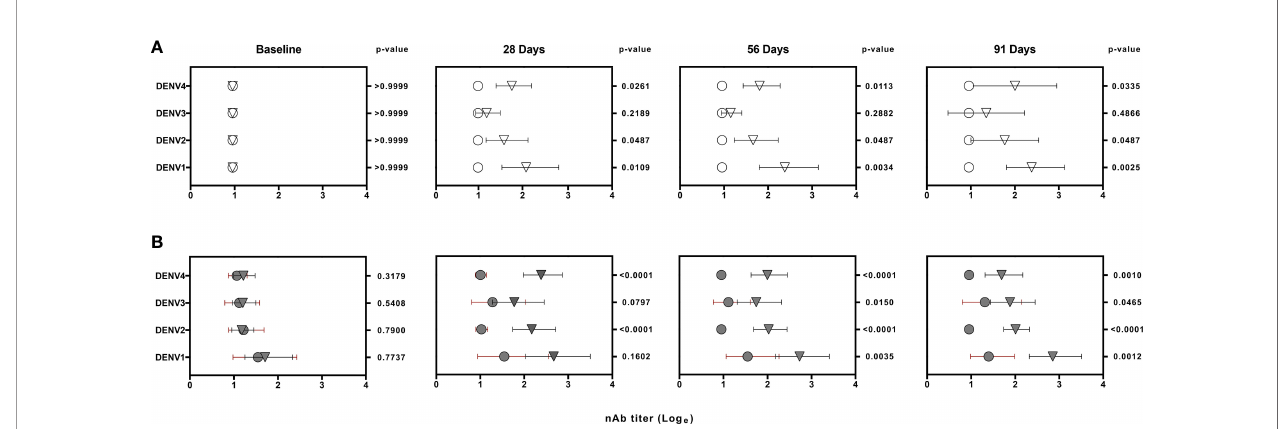
FIGURE 2 | Logarithm-transformed DENV neutralizing antibody (nAb) titers from naïve (white) (A) and DENV pre-exposed (gray) (B) volunteers at baseline and post- vaccination. Data was generated by 50% plaque-reduction neutralization titer assay (PRNT50). Circles and triangles represent median log titers for each DENV serotype in placebo and vaccinees volunteers, respectively. Horizontal lines span the 25 th -75 th percentiles (interquartile range). The values on the right of each time point column represents the p-values obtained after the analysis of placebo and vaccinees nAb titers using non-parametric Wilcoxon rank-sum test.